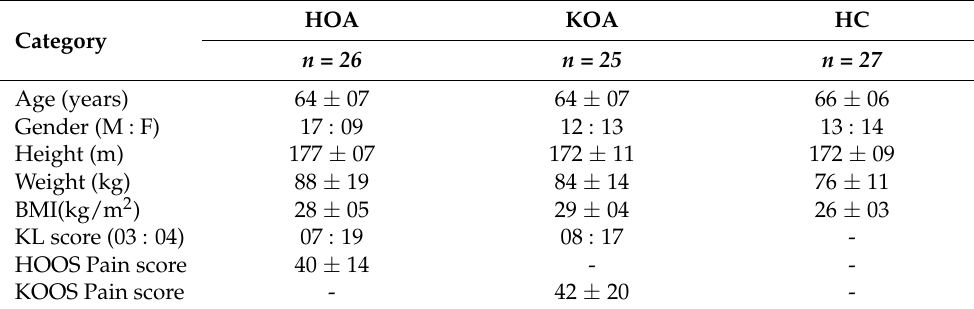
Table 3. Demographic data and clinical information of the study